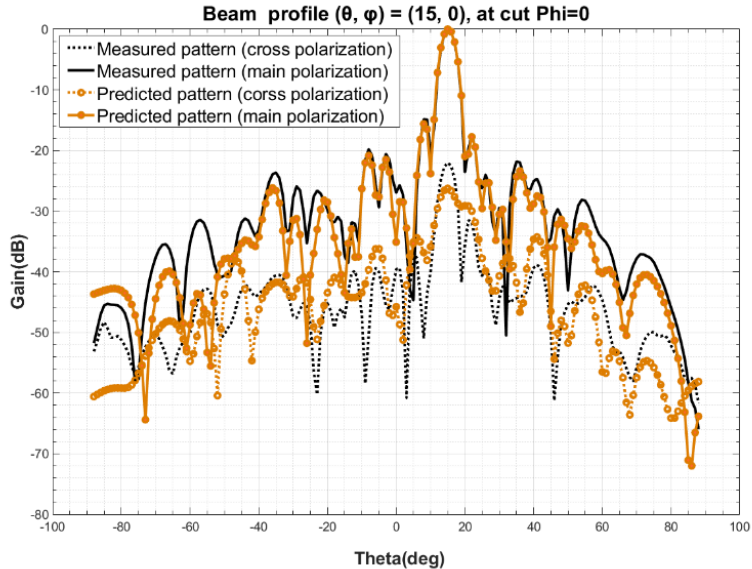
Figure 4. Comparison of predicted and measured beam profile at ( θ , ϕ ) = (15, 0).